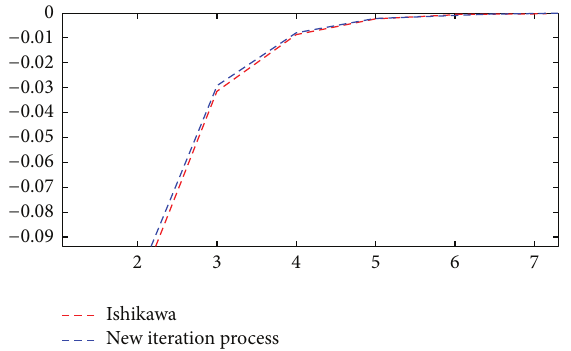
Figure 2: It shows the derivative functions of the Ishikawa and new iteration